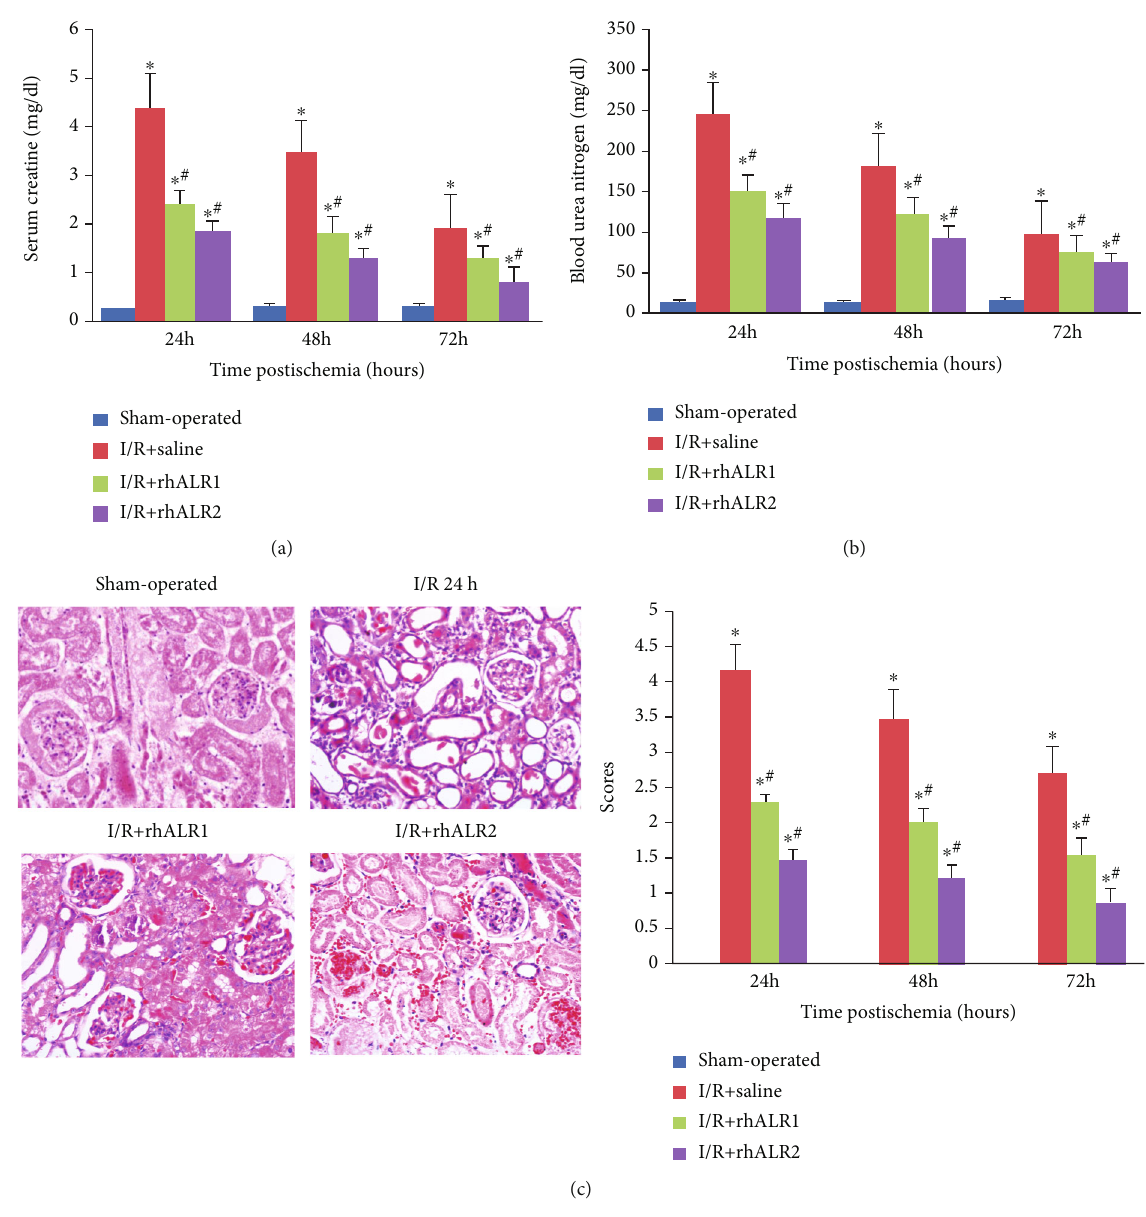
Figure 1: rhALR attenuates renal damage after I/R injury induction. (a, b) After 60min of bilateral renal ischemia, blood samples were collected at 24, 48, and 72h, followed by renal reperfusion, and serum creatinine and blood urea nitrogen were measured. The increase of two indexes in the rhALR1 and rhALR2 groups was withdrawn ( P < 0 : 05 ). Urea nitrogen and serum creatinine in the I/R+rhALR2 group were lower than those in the I/R+rhALR1 group ( P < 0 : 05 ). (c) HE staining of 24 h renal slices in the I/R group showed severe renal tubule necrosis. Renal morphology was preserved after rhALR1 and rhALR2 treatment (magni fi cation, × 200). Histological changes were assessed semiquantitatively for tubular necrosis. The tubular damage score was given by two uninformed observers. Data were expressed as the mean ± SD . ∗ P < 0 : 05 as compared to the sham group, and # P < 0 : 05 as compared to the I/R+saline